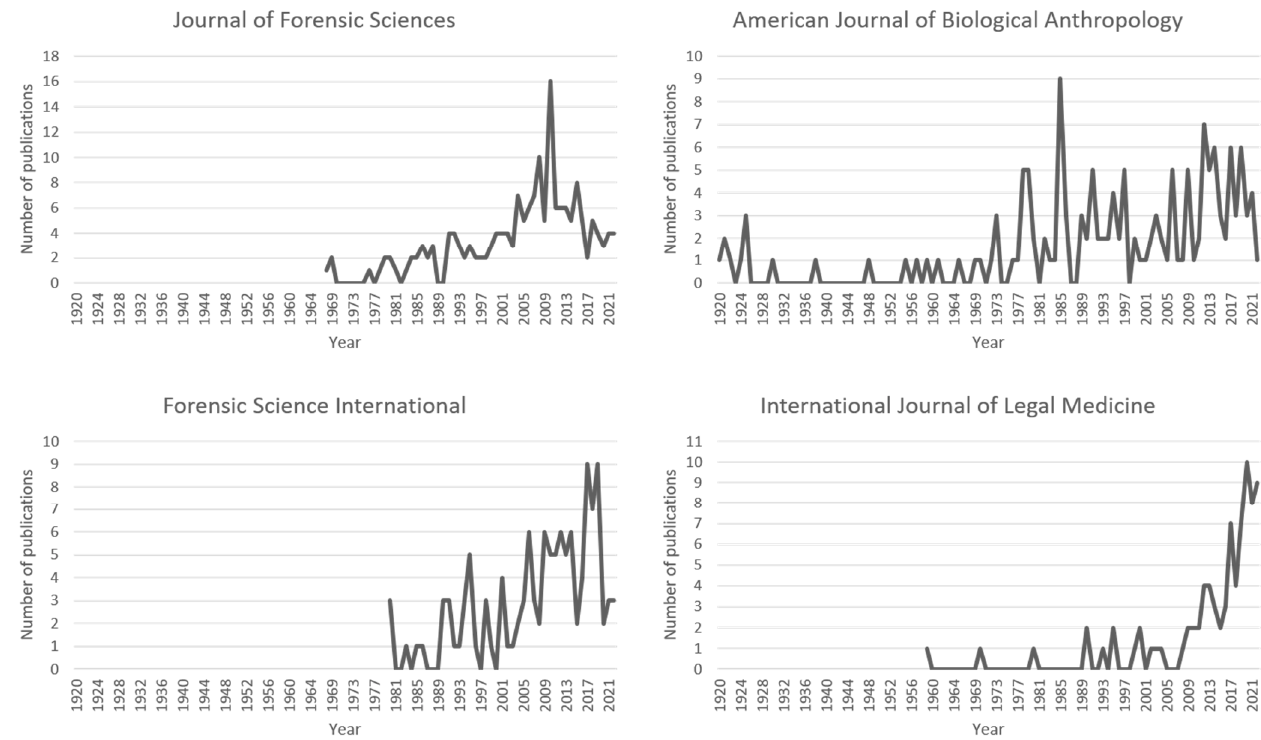
Figure 6. Distribution of the number of publications per year for the TOP4 journals.